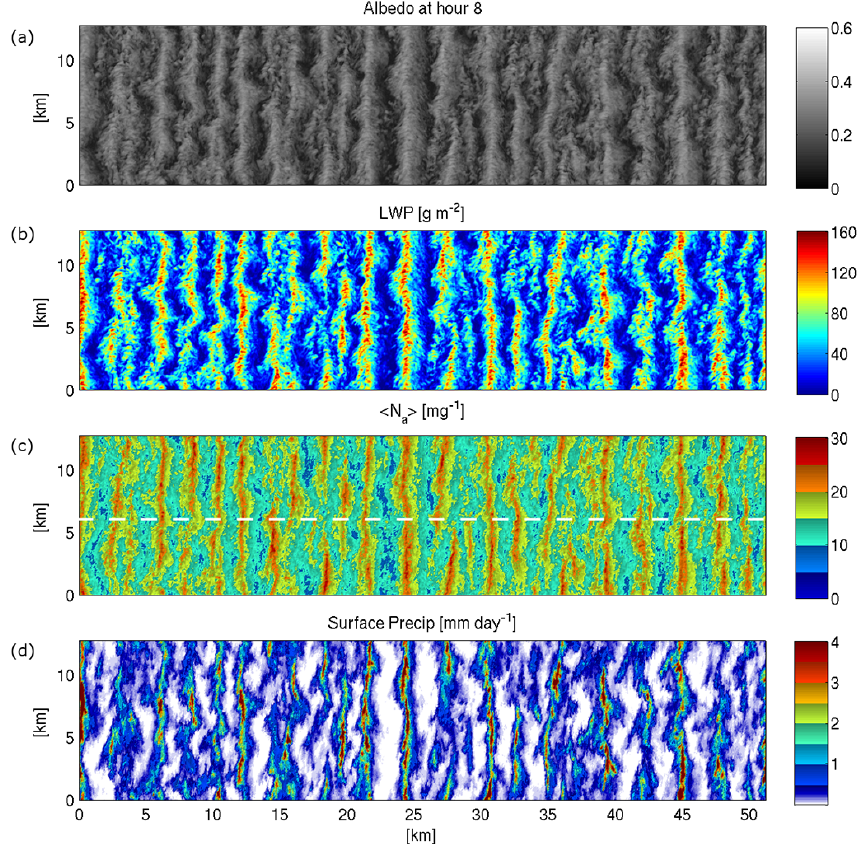
Figure 4. x – y snapshots of domain (a) albedo A , (b) liquid water path (LWP), (c) total aerosol number concentration (cid:104) N a (cid:105) , where brackets denote an average through the boundary layer depth, and (d) surface precipitation rate (0.05mmday − 1 threshold) for run BaseTrack at hour